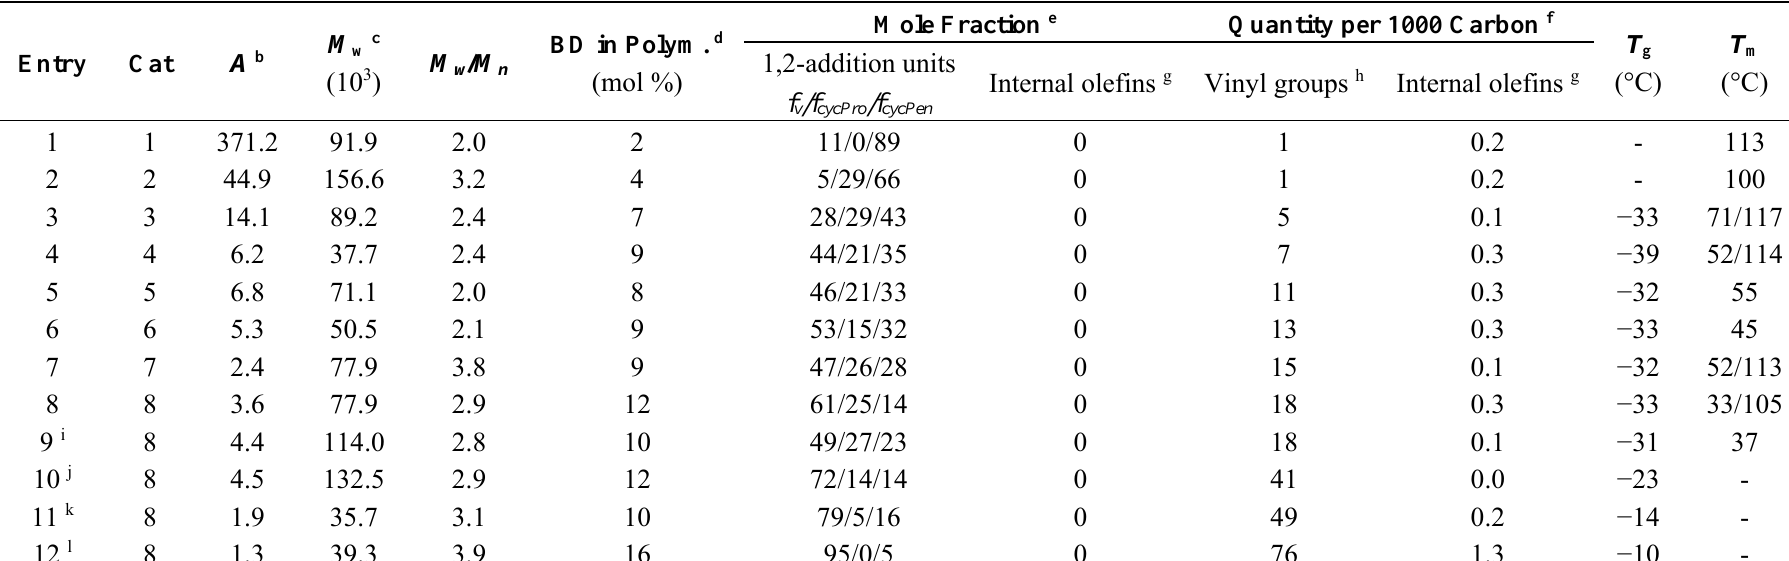
Table 1. Ethylene/butadiene copolymerization results for complexes 1 – 8 a